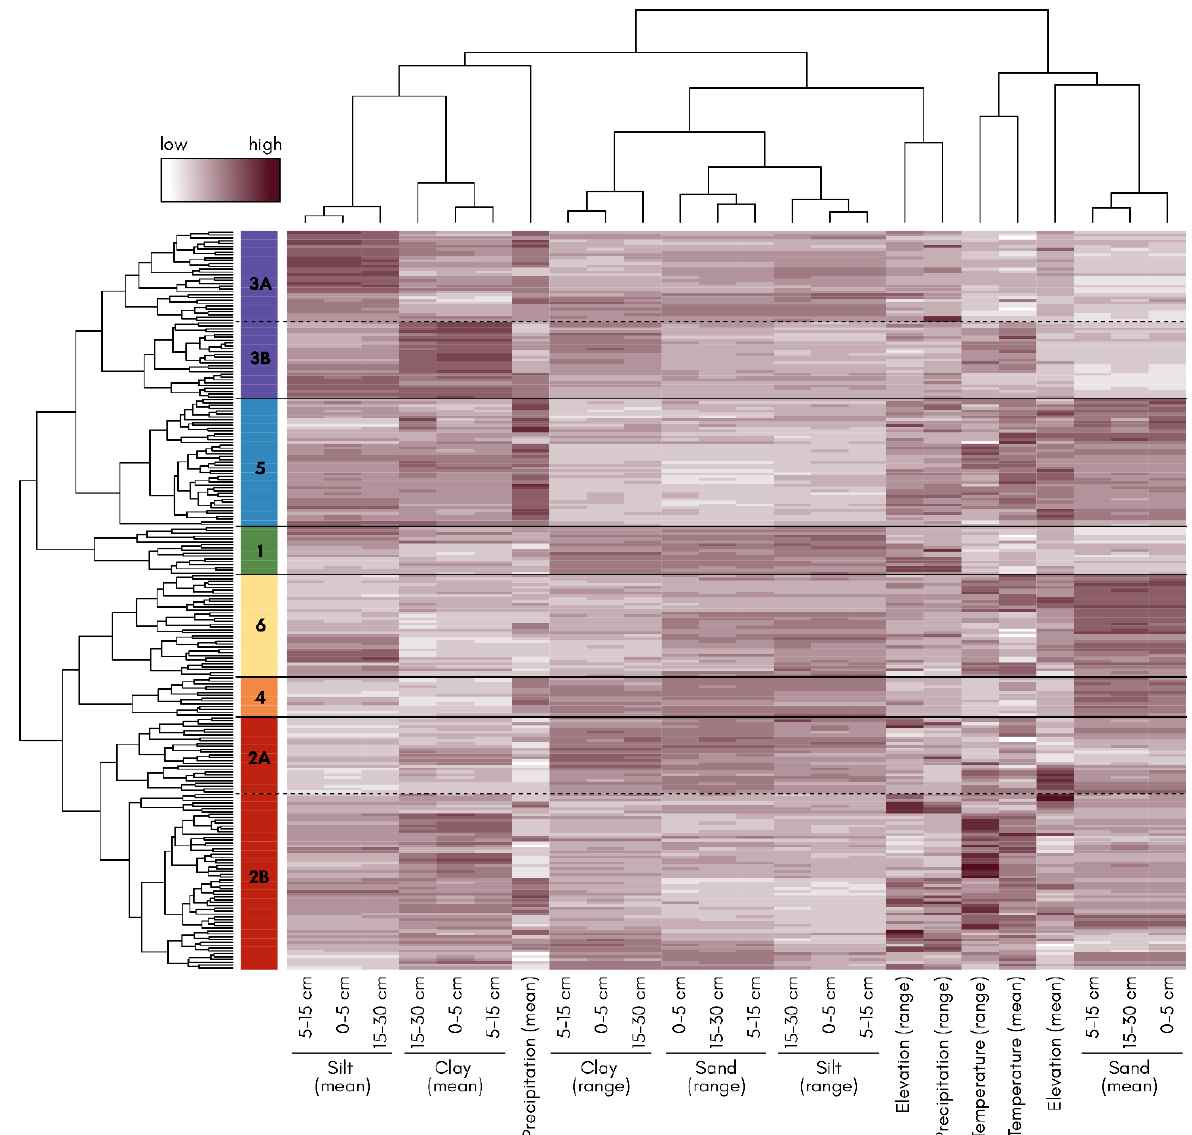
Figure 3 . Heatmap illustrating the relationship between the sites and the environmental